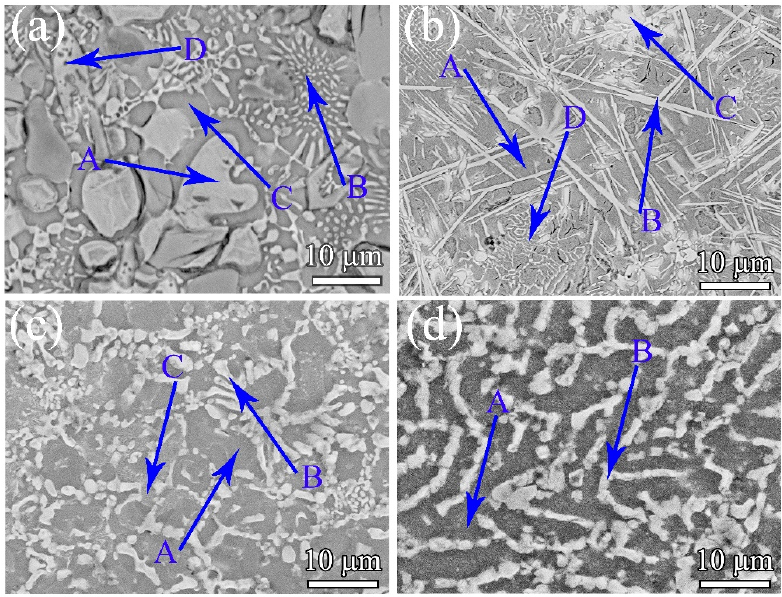
Figure 4. Microstructures of ( a ) Al 19.9 Li 30 Mg 35 Ca 10 Si 5 Y 0.1 ULW-CCA, ( b ) Al 15 Li 35 Mg 35 Si 5 Ca 10 ULW-CCA, ( c ) Al 15 Li 38 Mg 35 Ca 0.5 Si 1.5 ULW-CCA and ( d ) Al 15 Li 39 Mg 35 Ca 0.5 Si 0.5 ULW-CCA. Table 3. Chemical compositions (at.%) of phases identified in the microstructures of